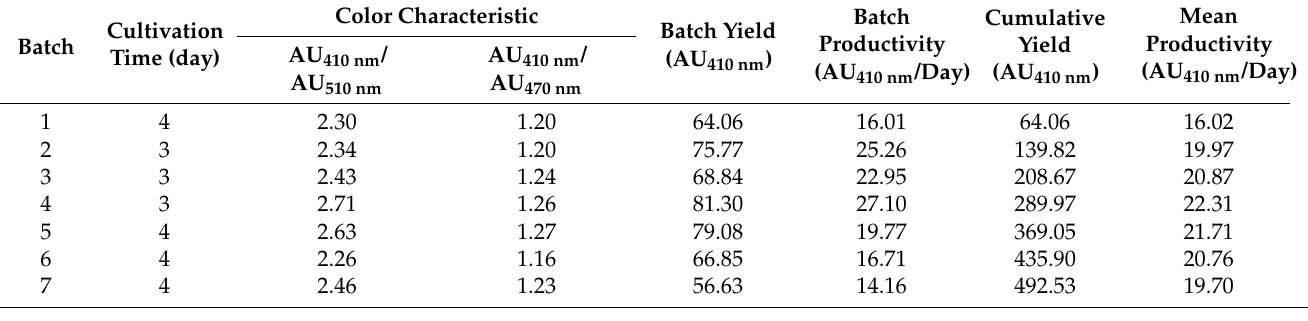
Figure 6. Biomass and intracellular pigment concentration at the end of each batch in repeated-batch extractive fermentation with immobilized cells.